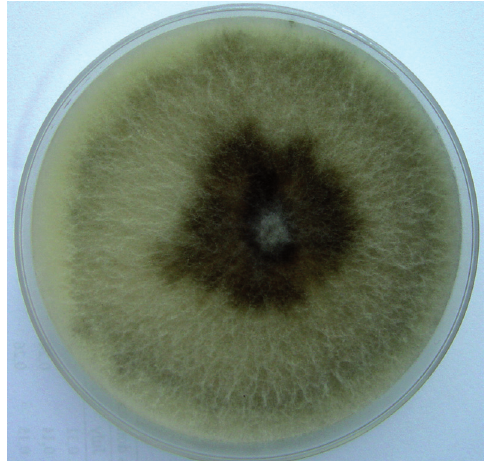
deviation.Figure 3. Isolate (DA1) of Diplodia africana grown on PDA for 7 days at 25°C in the